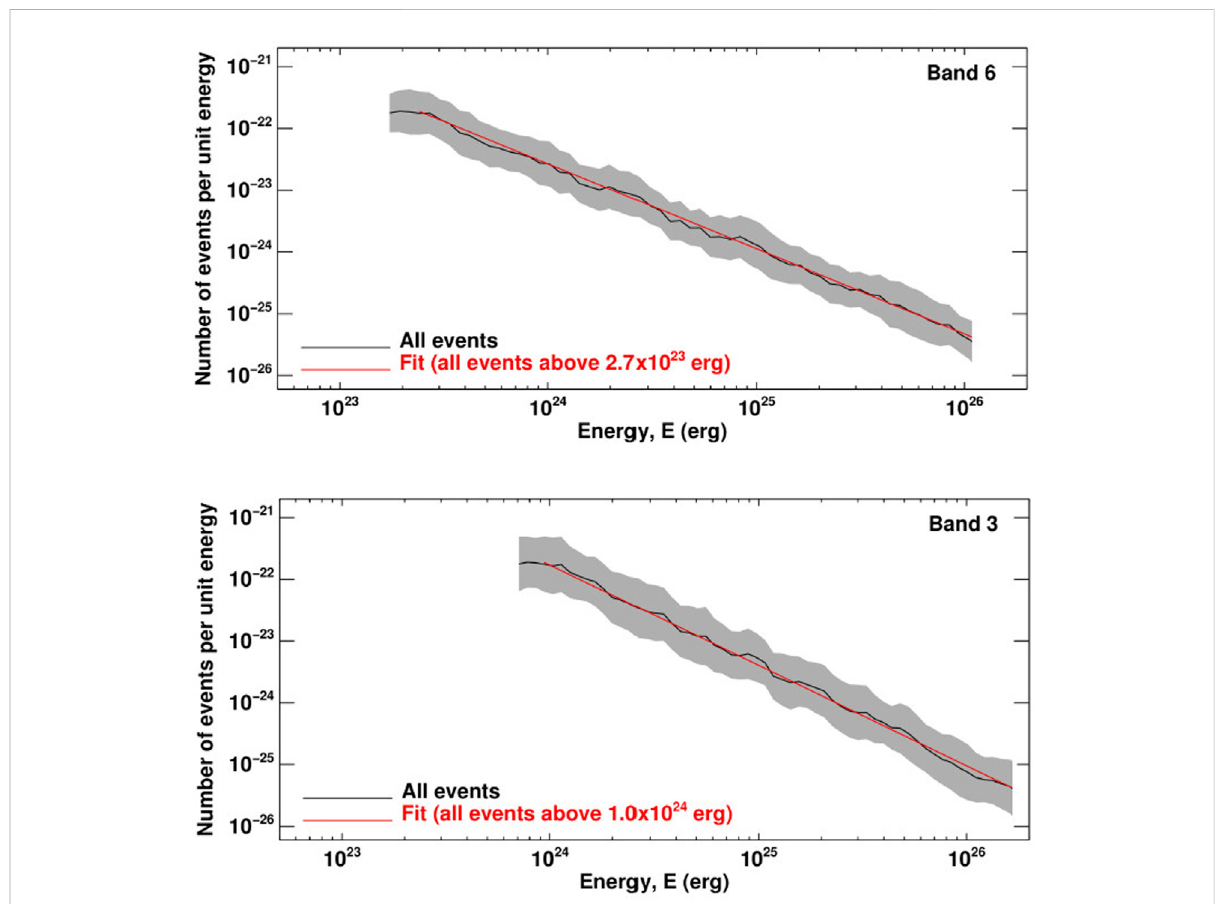
FIGURE 12 Energetics of quiet Sun ALMA transients. In the top panel, the black curve outlines the frequency distribution of 1.25-mm transients. The gray bandmarkstheuncertaintieswhiletheredlinerepresentsthepower-law fi t(withindexof1.64)ofthefrequencydistributionforenergies > 2 . 7 × 10 23 erg.Inthebottompanel theenergeticsof3-mmtransientsareshownwithalayoutindenticaltothetoppanel.The onlyexceptionisthattheredline representsthepower-law fi t(withindexof1.73)ofthefrequencydistributionforenergies > 10 24 erg(fromNindosetal.,2021).Reproducedwith permission ©